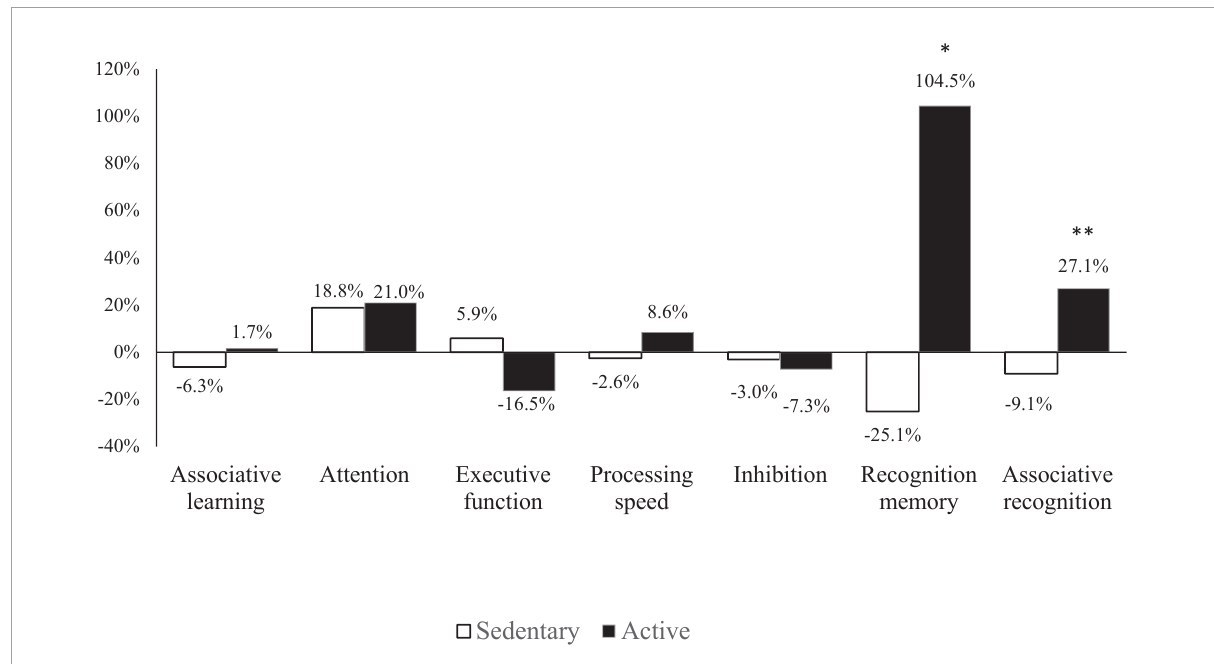
FIGURE3 Percent change ( (cid:49) %) of cognitive functions for sedentary and active groups. ∗ Significant difference: p < 0.05; ∗∗ significant difference: p <